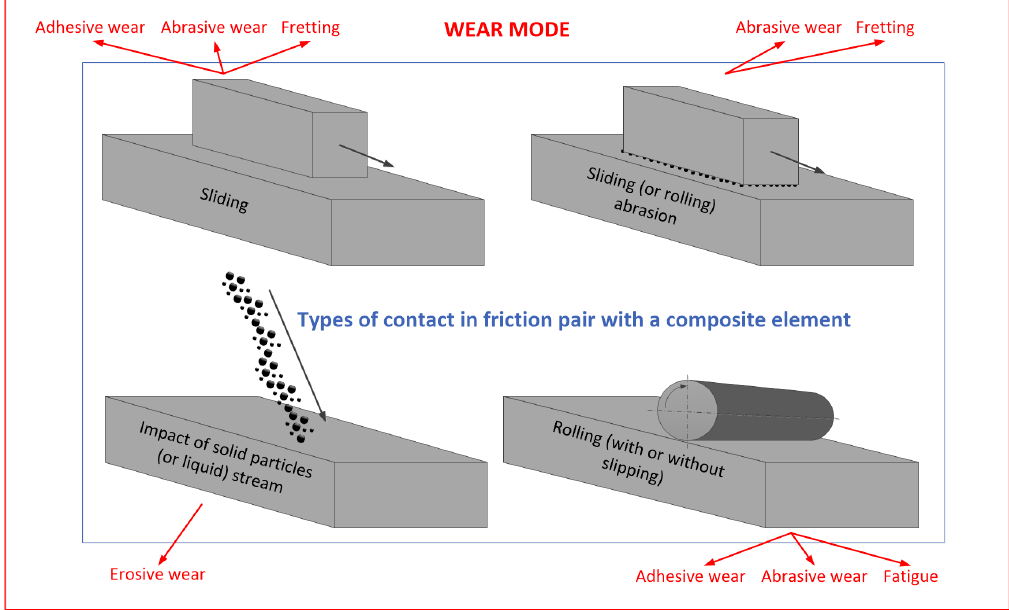
Figure 1. Types of contact between triboelements and the resulting wear